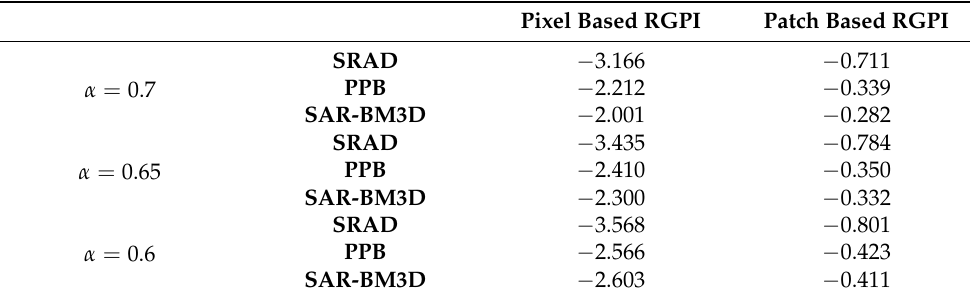
Table 3. RGPI values for the simulated data with different degree of speckle correlation. Pixel Based RGPI Patch Based RGPI SRAD − 3.166 − α = 0.7